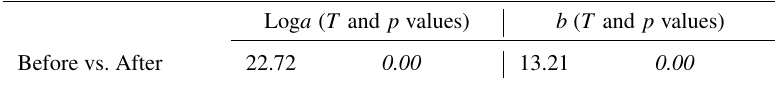
Table 3. Results of t tests on model parameters for the relationship between Log normalized Q and Log SSC, before and after channel